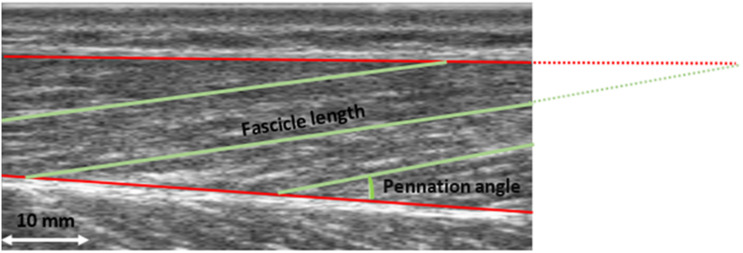
Ultrasound image of the m. vastus lateralis. Fascicle length and pennation angle were determined for three fascicles. Pennation angle was calculated between the muscle fascicle and the deep aponeurosis. Fascicle length was defined as the distance between the intersection of the upper aponeurosis with the muscle fascicle and the intersection of the lower aponeurosis and muscle fascicle. The mean of the three measured values was used for further analysis.